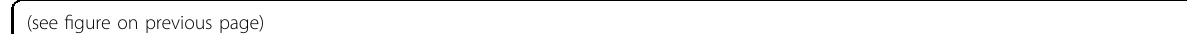
Fig. 3 Immunogenicity and protective ef fi cacy in BALB/c mice. a Schematics of vaccine immunization and challenge in female BALB/c mice (6 – 8-week-old). Mice ( n = 6) were immunized with 2 × 10 10 vp of AdC68-S or AdC6-S (day 0), and the prime-boost groups were boosted with the same dose of heterologous chimpanzee adenoviral vaccine (day 0 and day 30) via the i.m. route. Mice of control groups were vaccinated with 2 × 10 10 vp of single-dose AdC6-empty and AdC68-empty (day 0), respectively. Blood samples were collected for antibody titration before SARS-CoV-2 challenge. Mice were i.n. infected with 8 × 10 9 vp of Ad5-hACE2 at day 57 after initial immunization and challenged with 5 × 10 5 TCID 50 SARS-CoV-2 via the i.n. route at fi ve days post transduction. Three days post challenge, mice were euthanized, and lung tissues were harvested for virus titration and pathological examination. b Serum samples were collected before challenge (day 56) and live virus-neutralizing antibodies NT 50 titers were assessed. c SARS-CoV-2 viral titers of lung tissues were measured using RT-PCR probing virus genome RNA. Dotted lines indicate the LLOD. Values below the LLOD were set to half of the LLOD. d Copies of SARS-CoV-2 viral sgRNA in lungs. e Tissue sections of the lung tissues of six mice per group were stained with H&E for pathological examination, and representative photomicrographs of both low magni fi cations (scale bars, 200 μ m) and high magni fi cations (scale bars, 50 μ m) from each group are shown. All data were shown as means ± SEM. P -values were analyzed with one-way ANOVA ( ns P ≥ 0.05; * P < 0.05; ** P < 0.01; *** P < 0.001; **** P <